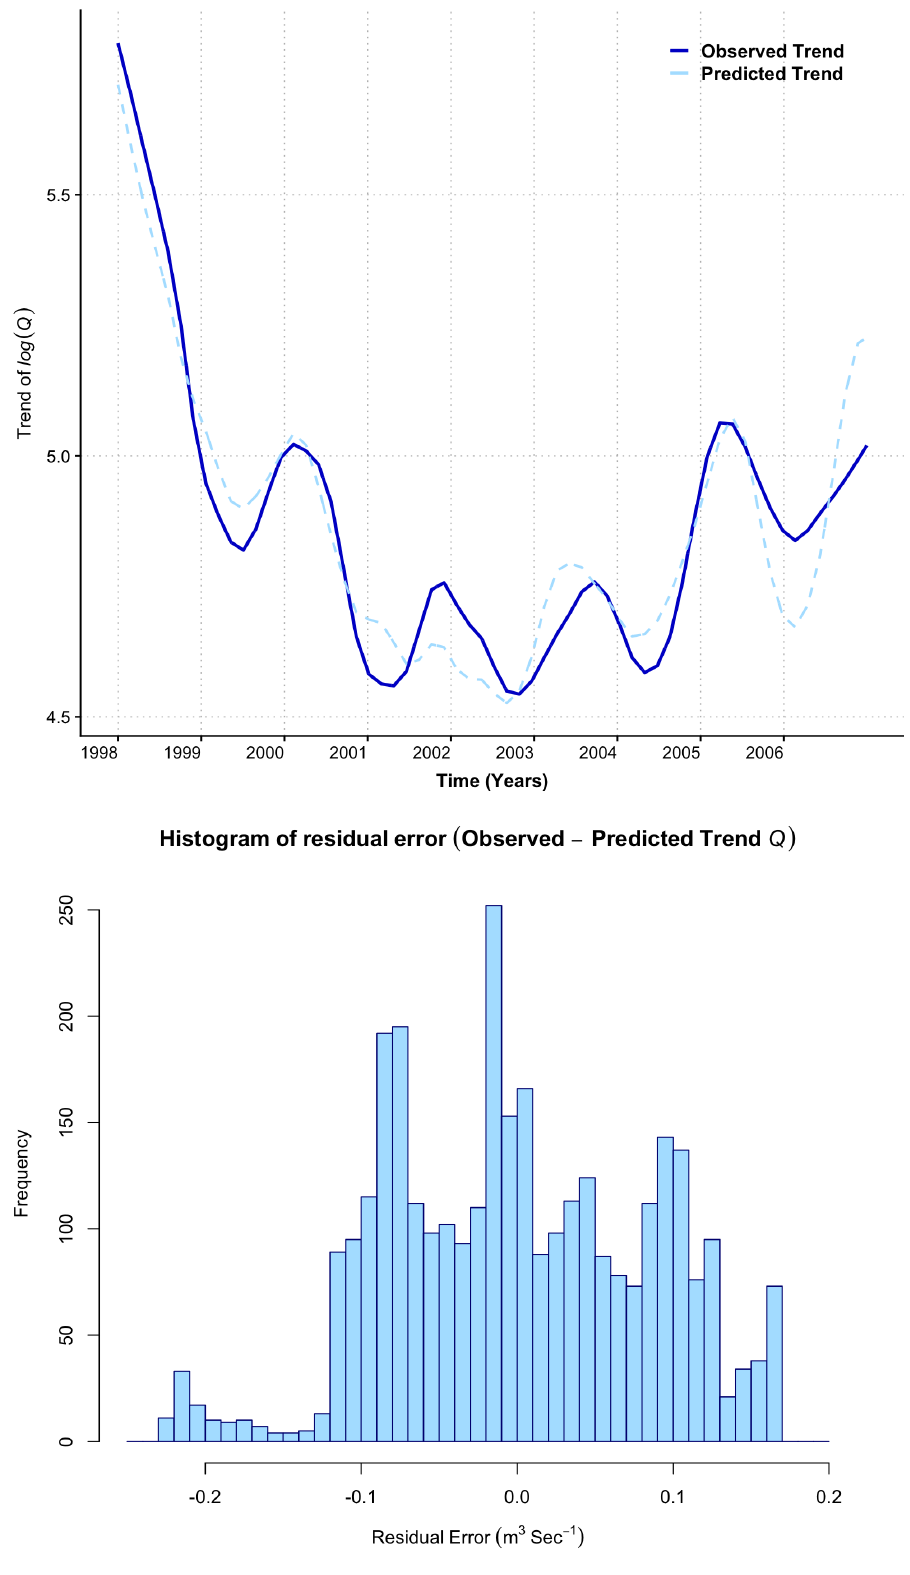
Figure 9. Upper panel: Compares observed trend component of log ( Q ) (solid lines in Navy) with predicted trends of log ( Q ) during the period 1998–2006 simulated by ‘climate module’ (dashed lines in light blue) in response to trend of log ( EV ) and log ( P ) as independent variables. Lower panel: histogram of residual error